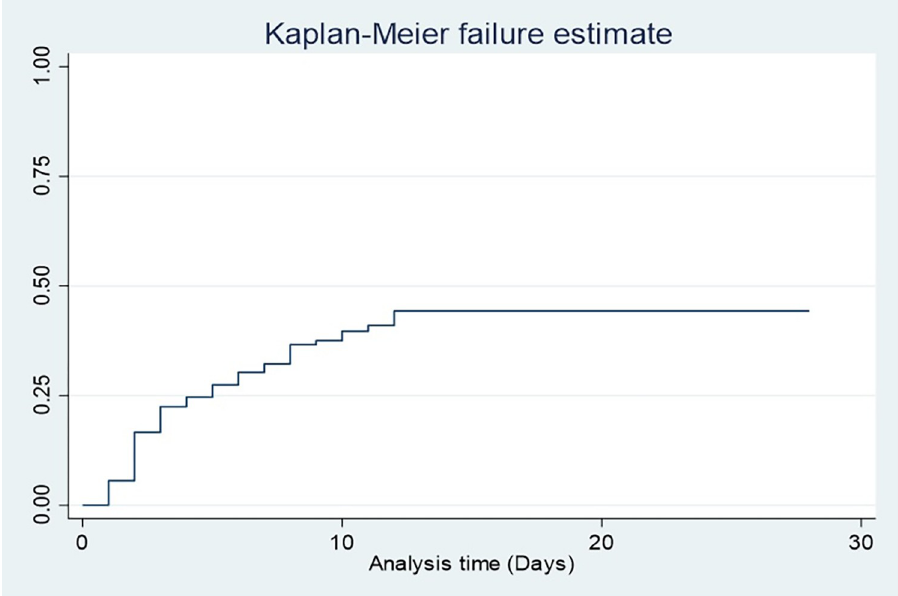
Fig 1. Kaplan-Meier failure estimate of asphyxiated newborns admitted to the NICU of DCSH, Amhara region, Northeast Ethiopia (N =